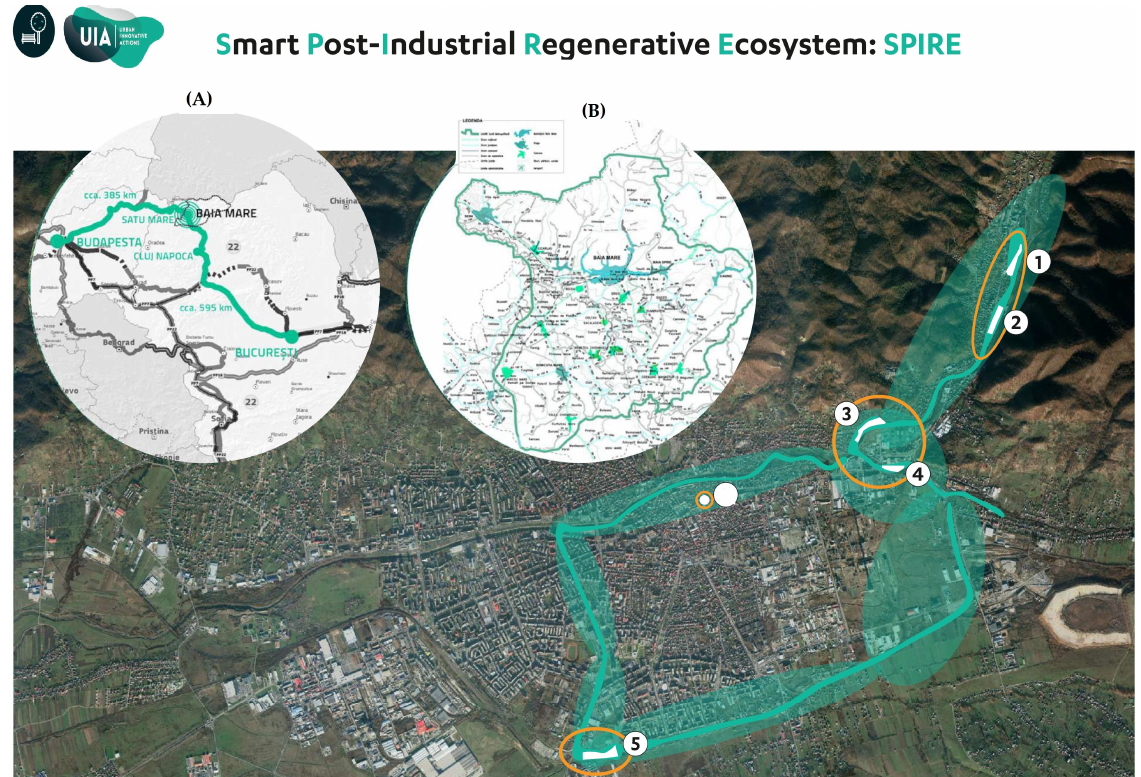
Figure 1. Location of the study sites. ( A ) The geographical location of Baia Mare city within Romania. ( B ) The Metropolitan area Baia Mare. (1) Romplumb. (2) Ferneziu. (3) Colonia Topitorilor. (4) Urbis. (5) Craica. (Source: Reproduced with permission from UIA SPIRE Baia Mare. Graphics Urbasofia).